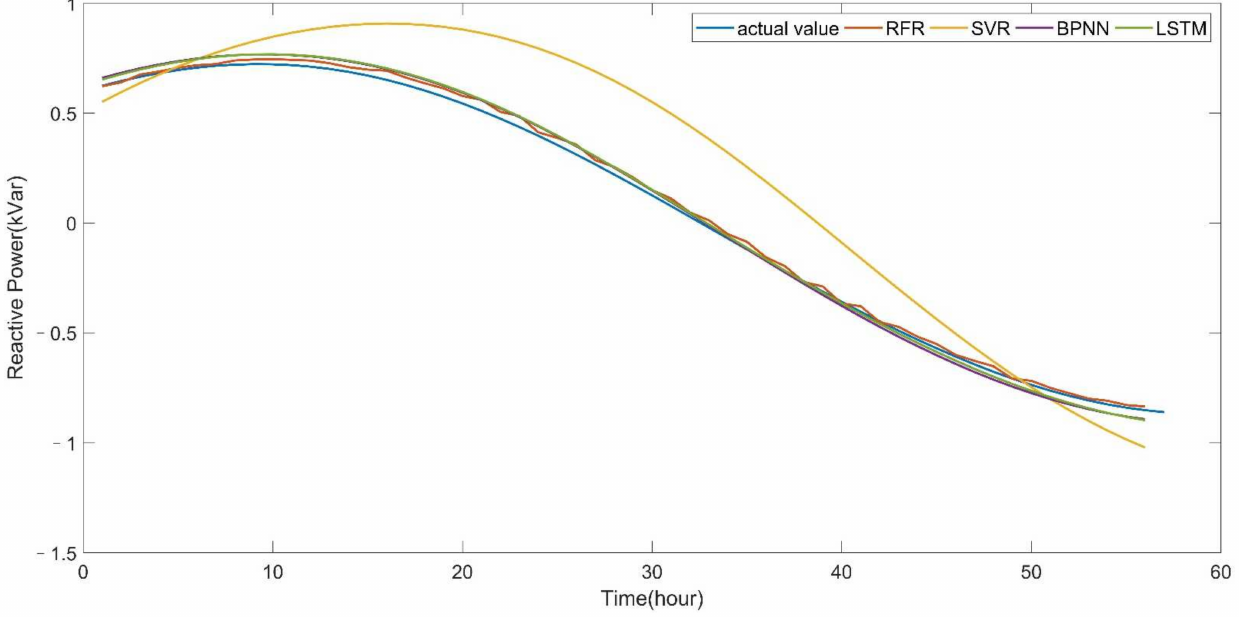
Figure 6. Forecasting on smooth sequences.